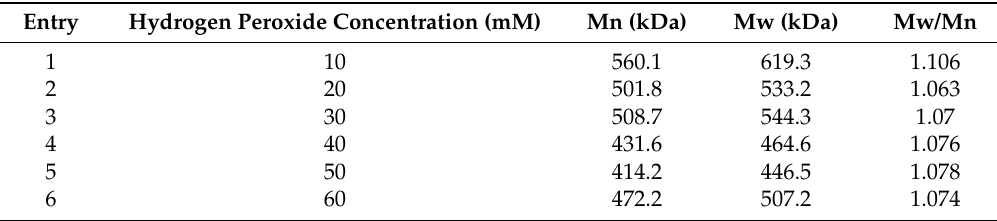
Table 1. Average molecular weights and dispersity indices of LMW-HA under different concentrations of hydrogen